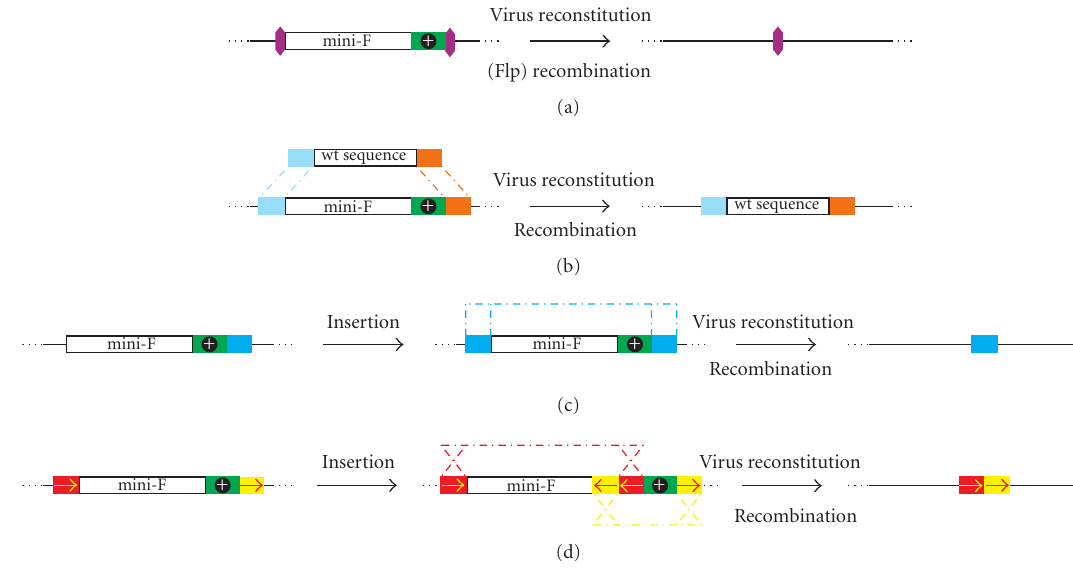
Figure 5: Overview of strategies that allow mini-F removal upon virus reconstitution. Positive selection marker is portion of the BAC vector backbone. Boxes of same color represent identical